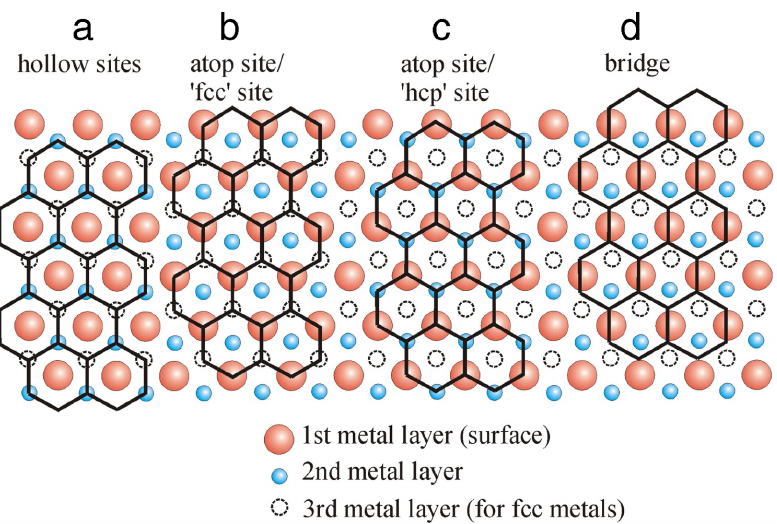
Figure 5. Four basic adsorption arrangements for non-rotated Gr on hexagonal (fcc(111) or hcp(0001)) metal surfaces: ( a ) hollow sites, ( b ) top-fcc sites, ( c ) top-hcp sites, ( d ) top-bridge sites. Adapted with permission from Reference [130]. Copyright 2012,